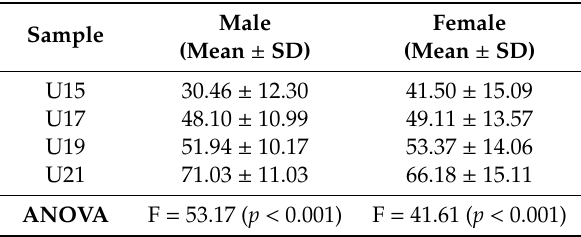
Table 5. Descriptive statistics of all subject groups’ Scores with F values